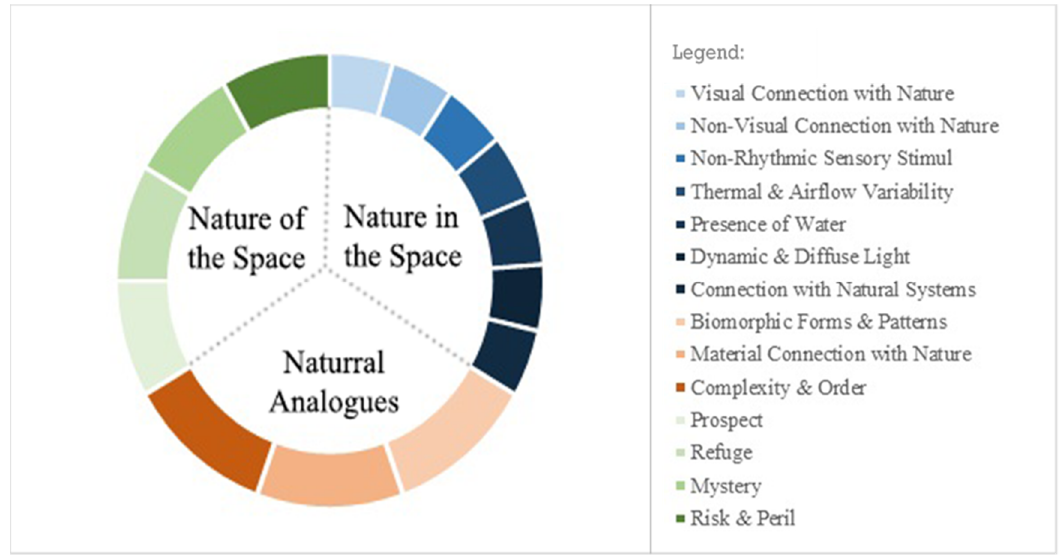
Figure 1. 14 Patterns of Biophilic design. Data from source: [28].